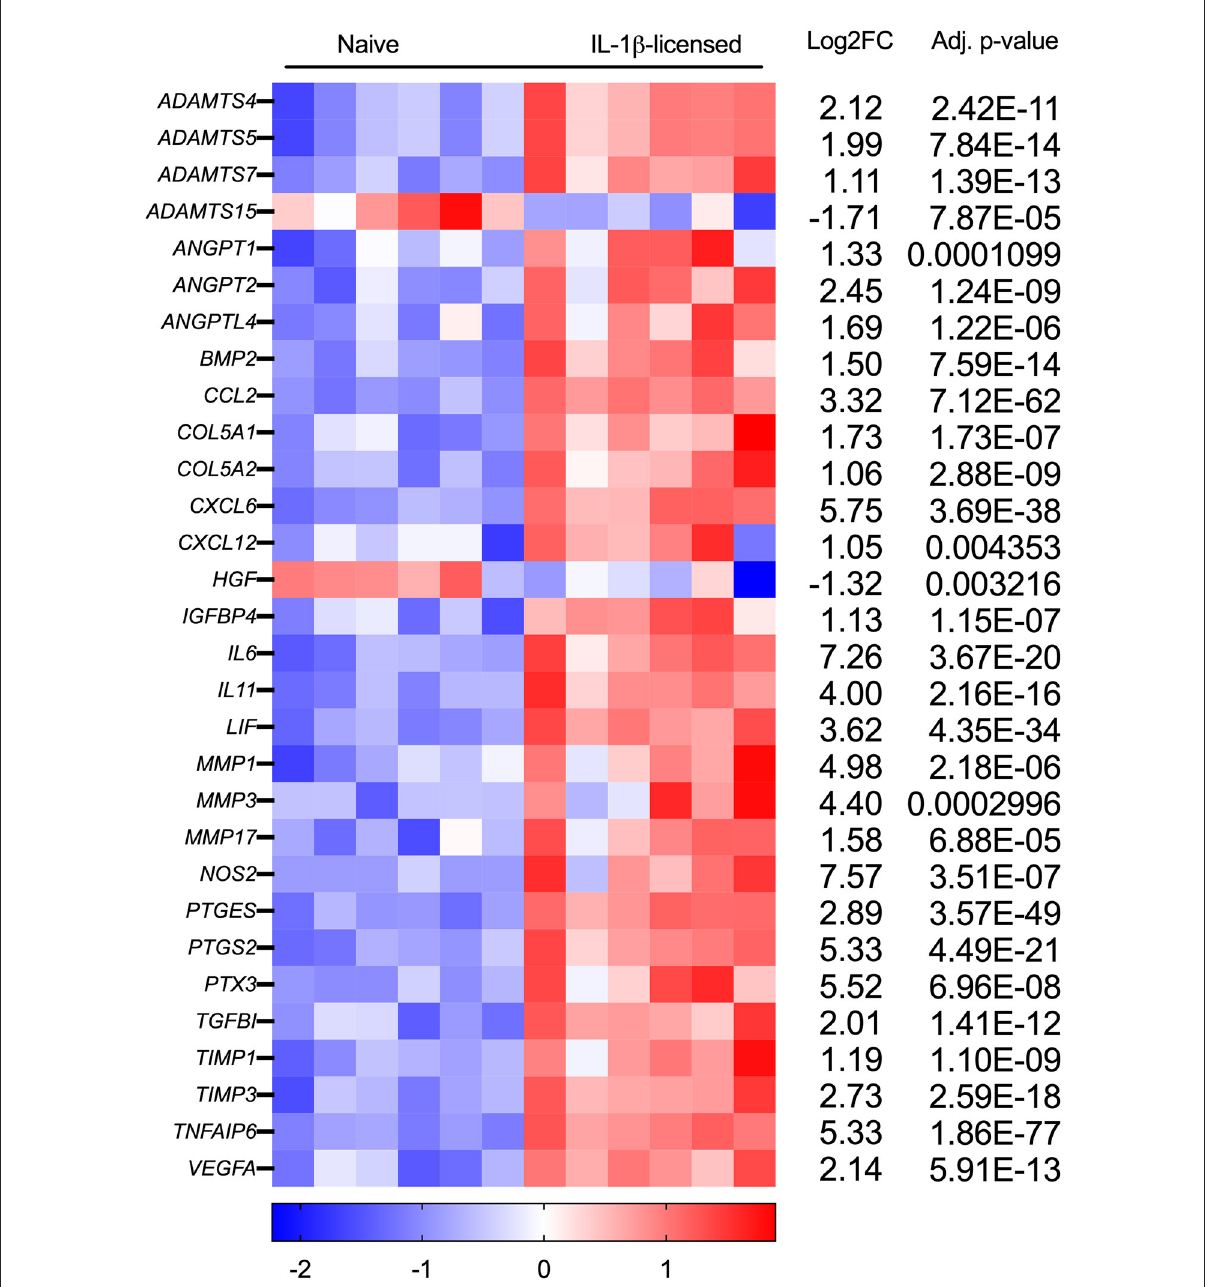
FIGURE4 Tendon-relevant genes are significantly differentially regulated in equine MSCs following IL-1 β licensing. Heat map representation using log2fold change of select significantly differentially expressed genes (DEGs) from RNA sequencing analysis following IL-1 β licensing ( n = 6 horses). Compared to naïve MSCs, gene downregulation is noted in blue and gene upregulation in red.